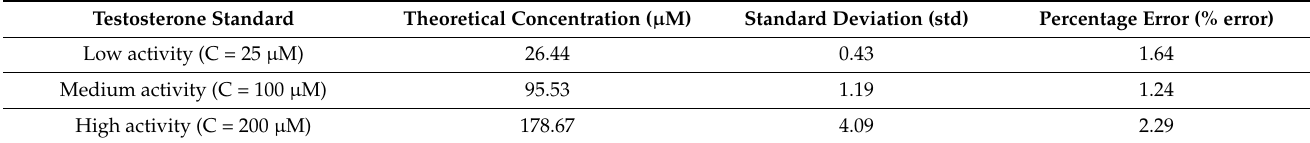
Table 7. Testosterone intra-assay precision data.